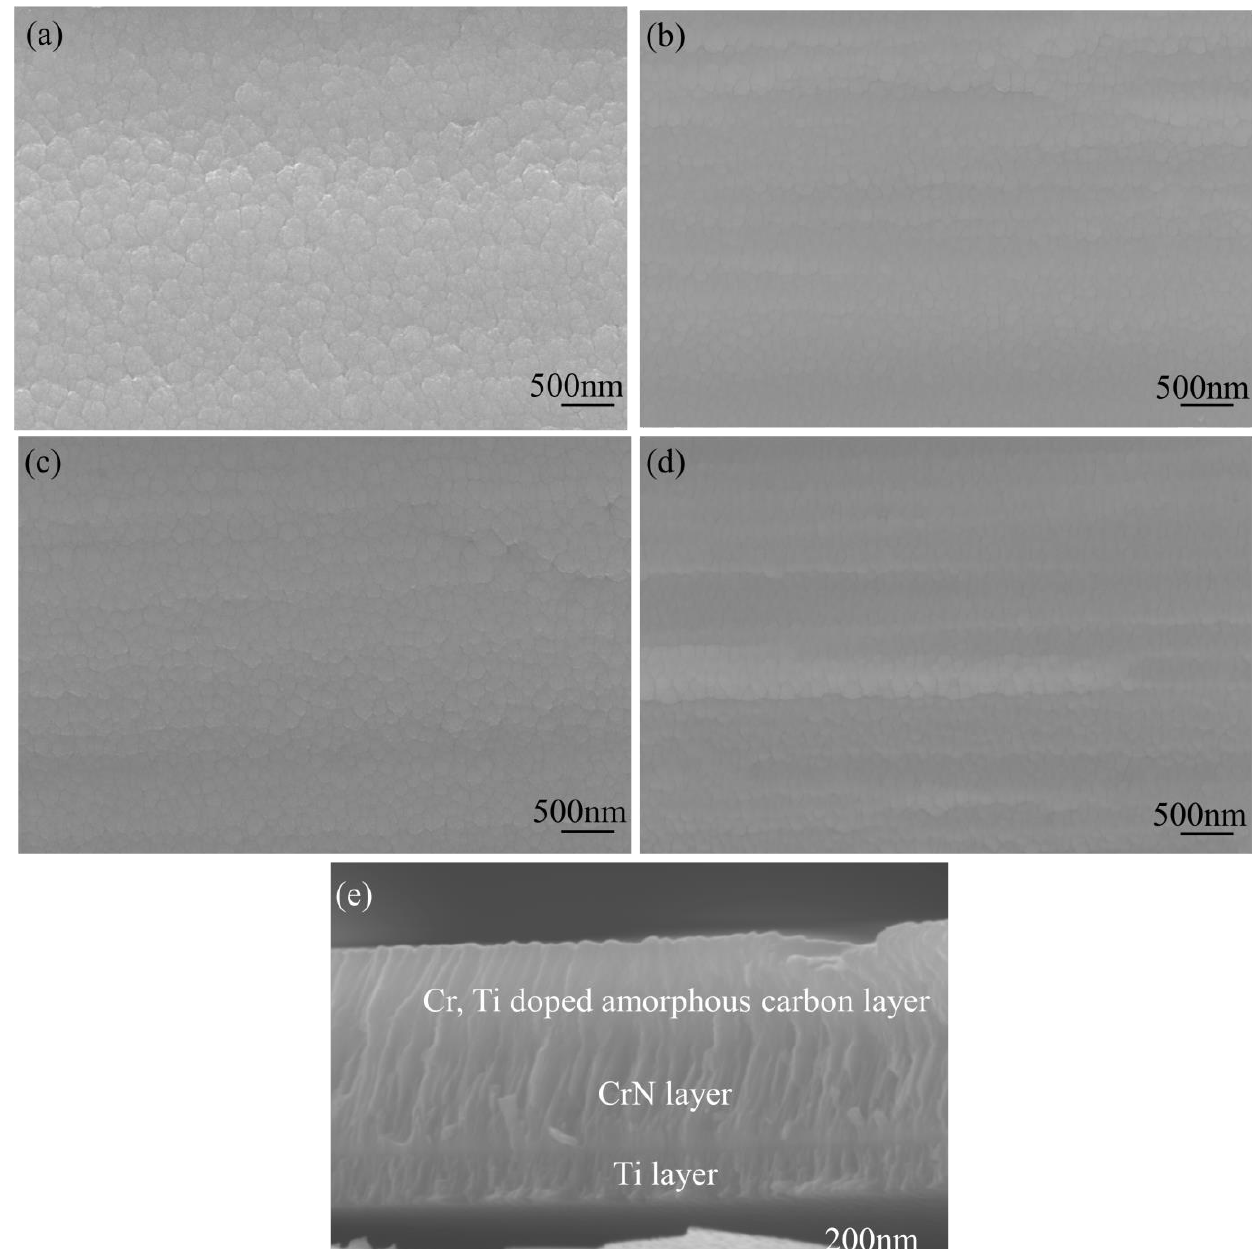
Figure 1. SEM images showing the changing of the Cr, Ti-doped amorphous carbon coating for different Ti concentrations; ( a ) Ti-0, ( b ) Ti-1, ( c ) Ti-2, ( d ) Ti-3, ( e ) cross-section of the Ti-2 film.